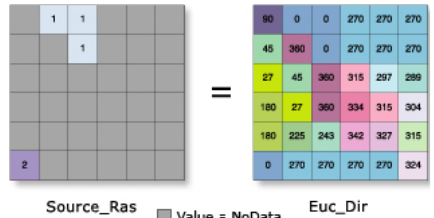
Figure 2. Euclidean direction calculation in ArcMap 10.5.